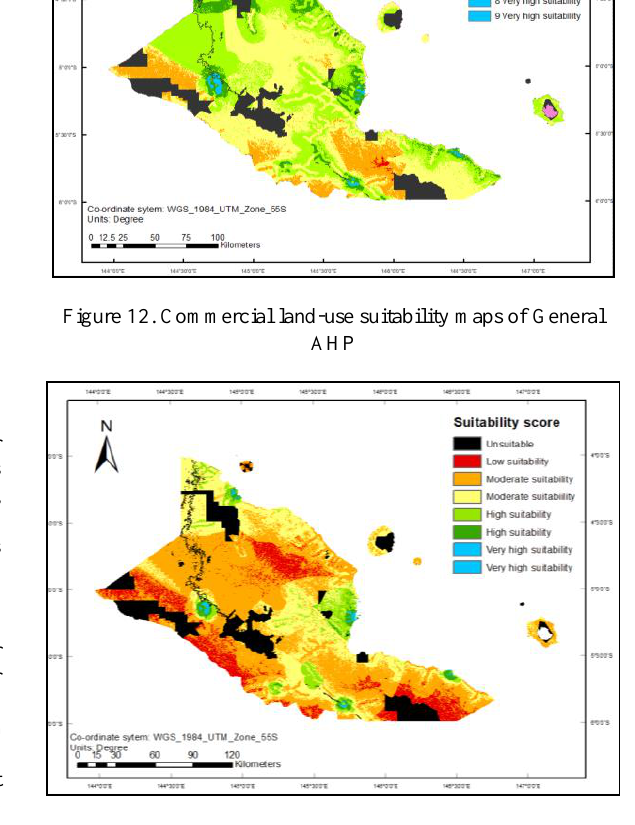
Figure 13. Commercial land-use suitabiluty maps of Multi- hazard AHP Table 4. Agricultural land-use coverage for different degree